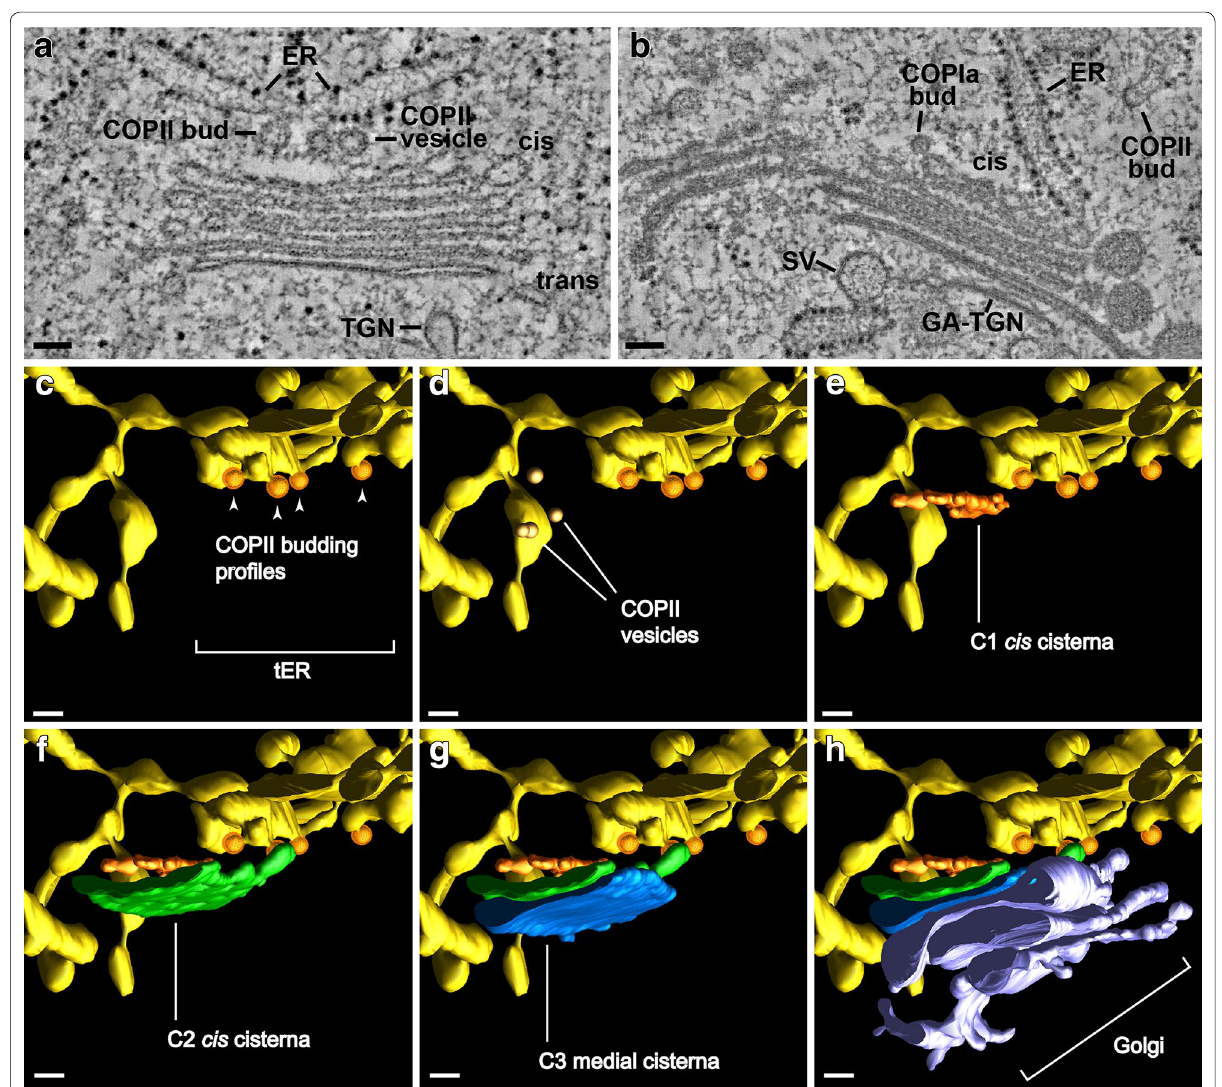
Fig. 8 ER (yellow) export sites with COPII buds and vesicles and associated cis - and medial Golgi cisternae. a Tomographic slice image illustrating a budding and a detached ~ 70 nm in diameter COPII vesicle sandwiched between an ER export site and the cis -side of a Golgi stack. b Tomographic slice image of an ER export site with a COPII vesicle bud, and a cis -Golgi cisterna displaying a ~ 45 nm in diameter COPIa vesicle bud. c – h Tomographic reconstructions illustrating the 3D architecture of an ER export site with budding and free COPII-type vesicles together with the C1 (orange), C2 (green), C3 (blue) cisternae, and remaining cisternae (purple) of a Golgi stack. Note that the ER region shown possesses two COPII vesicle-producing sites separated by a short tubular ER domain with the one on the right ( c ) producing COPII buds and the one on the left ( d ) exhibiting 4 COPII vesicles sandwiched between the ER cisternae and adjacent C1 and C2 cis cisternae ( e , h ). Bars 0.1